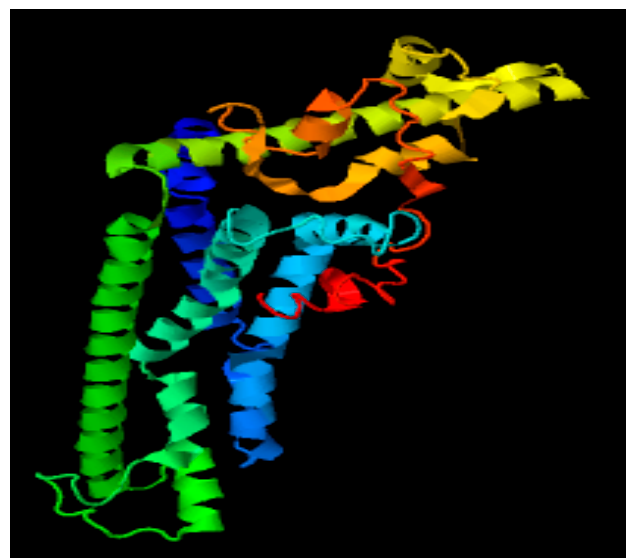
Figure 6. Best predicted model by MODELLER (6LMT A).